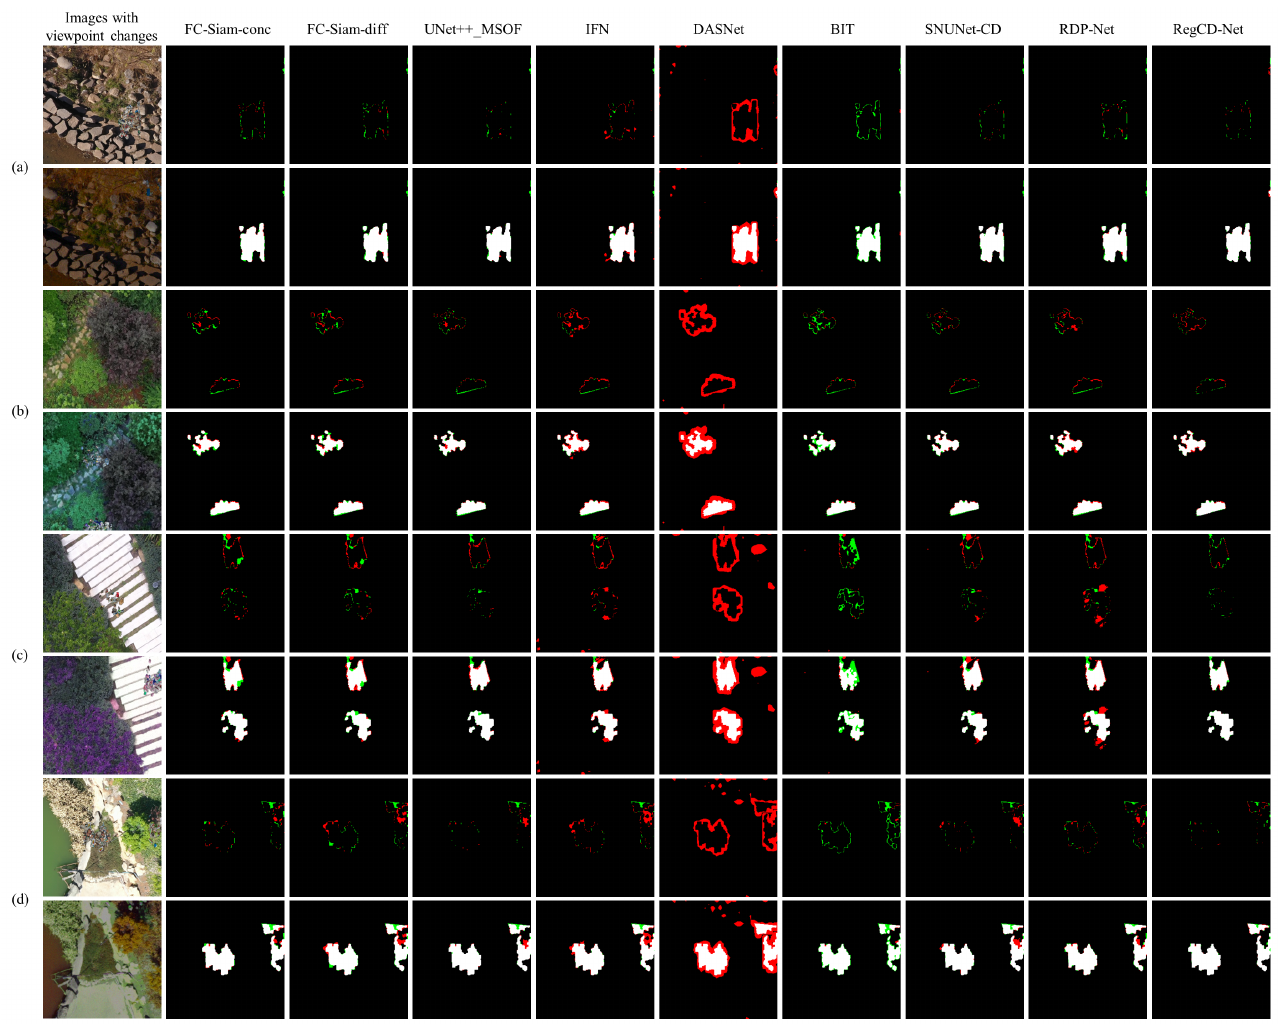
Figure 9. Visualization results of different methods on our dataset. Four groups of different bi- temporal images are marked with ( a – d ). Different colors are used for a better view, which is white for true positive, black for true negative, red for false positive and green for false negative. The change maps in the first row of each group only contain false positives and false negatives for better edge error